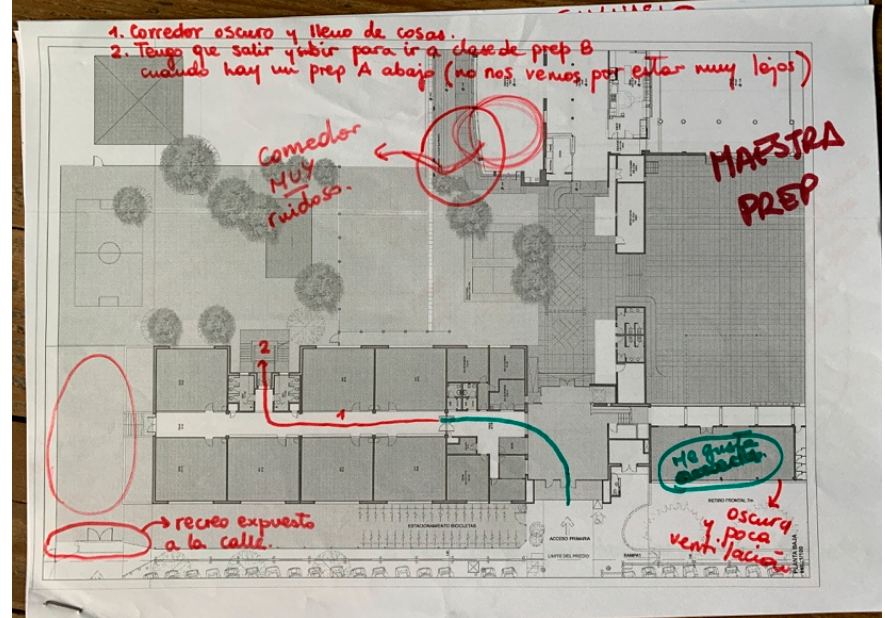
Figure 5. An example of a Uruguayan staff member’s mapping of a typical day.